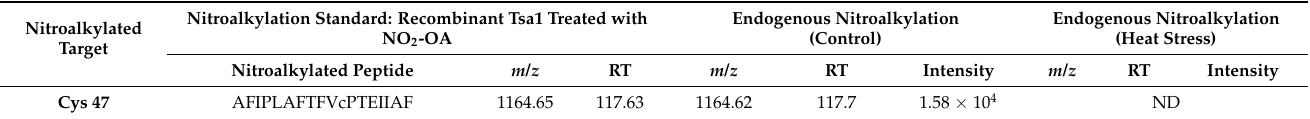
Table 2. The in vivo identification of the nitroalkylation targets in yeast Tsa1. The m/z and retention time (RT) parameters of the peptide containing nitroalkylated Cys 47 in both in vitro sample (recom- binant Tsa1 treated with NO 2 -OA) and control and heat stress yeast samples are shown. RT: retention time; ND: not